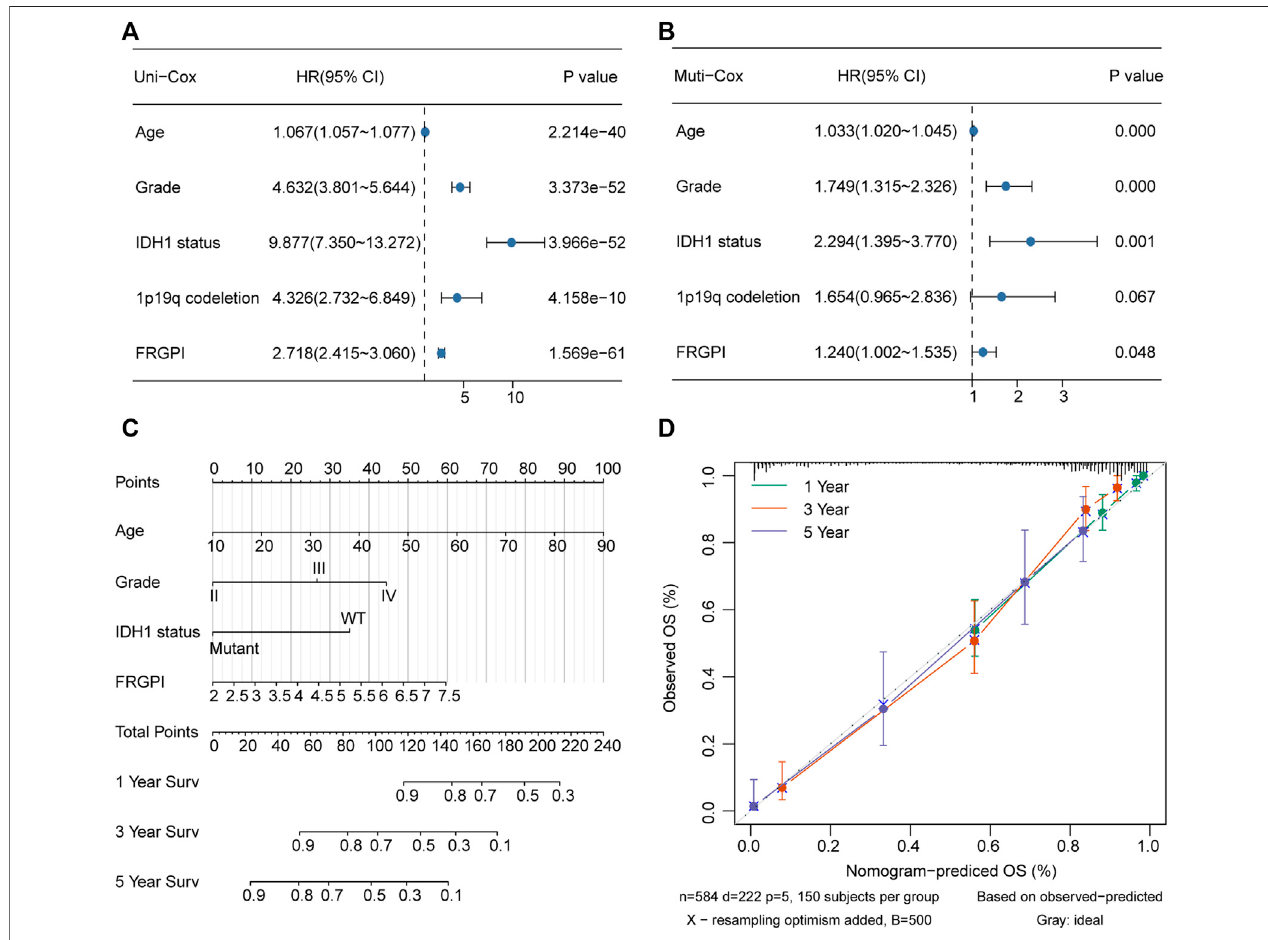
FIGURE6| Nomogram wasconstructed tocalculatedprognosticriskscoreforindividual. (A,B) Hazard ratioand p -valueofconstituentsinvolvedinunivariateand multivariate Cox regression for FRGPI, age, grade, IDH1 status and 1p19q codeletion in TCGA glioma samples. (C) Nomogram to predict the 1-, 3- and 5-year OS of glioma patients. (D) Calibration curve indicated that predicted 1-, 3- and 5-year survival rates were close to the actual survival rates. The gray dashed diagonal line represents the ideal nomogram, and the green line, red line and blue line represent the 1-, 3- and 5-y observed nomograms.